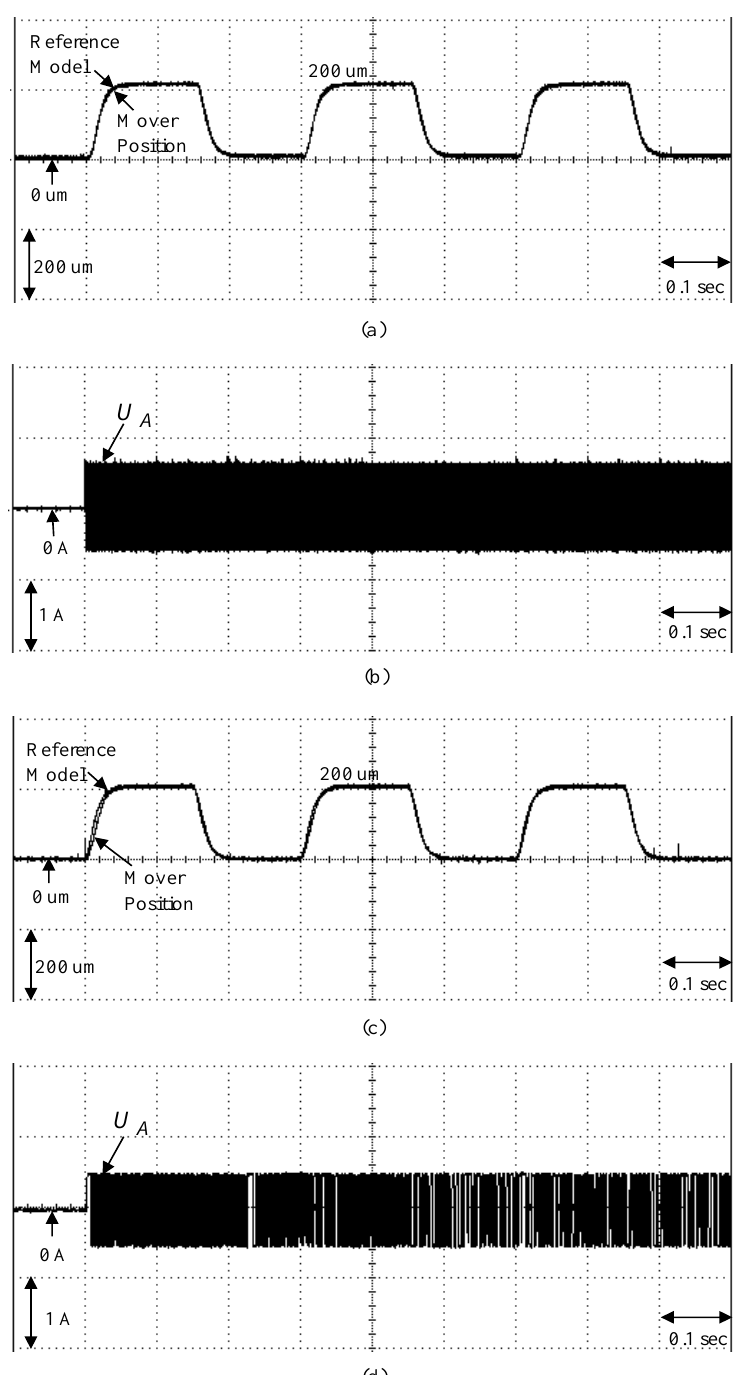
Figure 7. Experimental results of the micrometer backstepping control system using the switching function with an upper bound for the periodic step command: ( a ) mover position in the rated case; ( b ) control intensity in the rated case; ( c ) mover position in the parametric variation case; ( d ) control intensity in the parametric variation case.